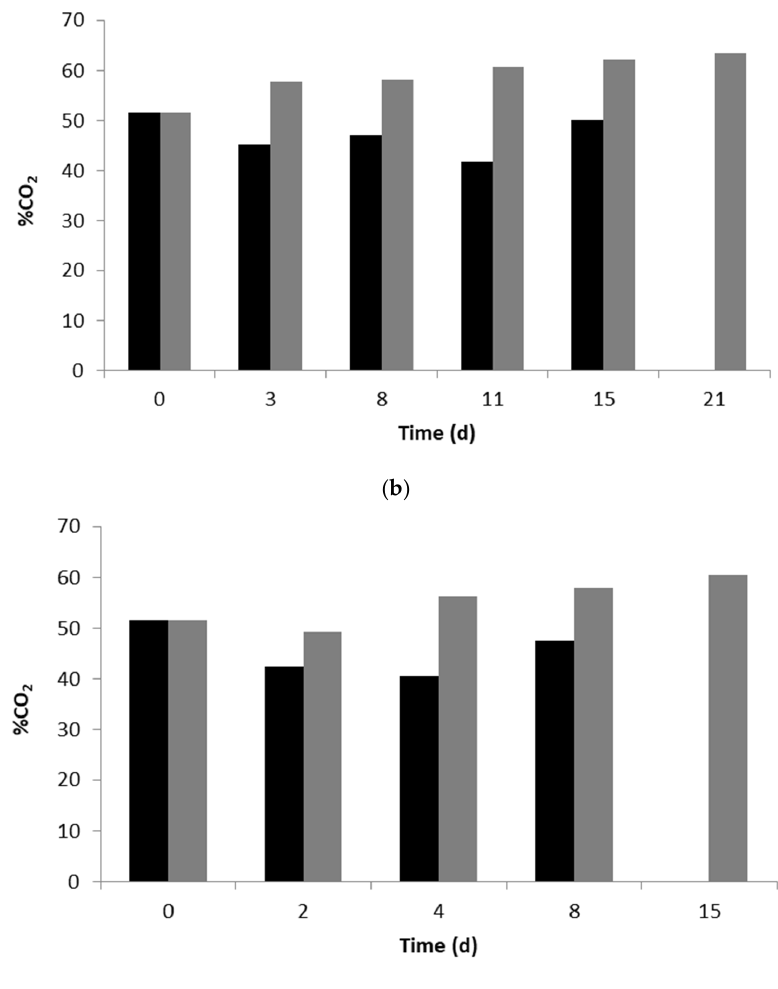
Figure 1. CO 2 concentration in the sea bass package headspace during the isothermal storage at ( a ) 0 °C, ( b ) 5 °C, and ( c ) 10 °C (grey bars ACT-MAP, back bars MAP). MAP: modified atmosphere packaging, ACT-MAP: active modified atmosphere packaging with CO 2 emitters.